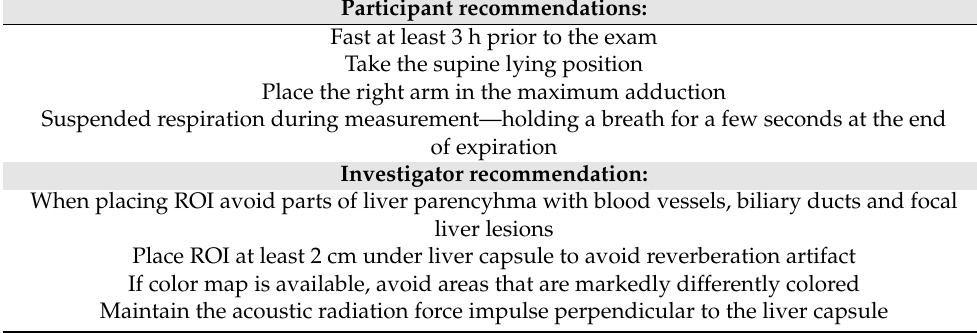
Table 3. General recommendations during US attenuation imaging